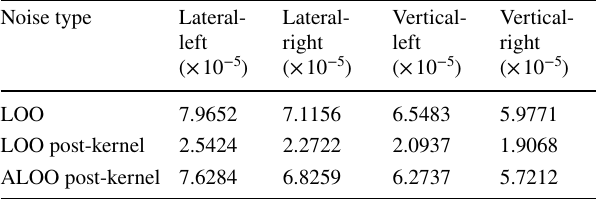
Table 5 Kernel error standard deviations of the various noise types and track displacement directions